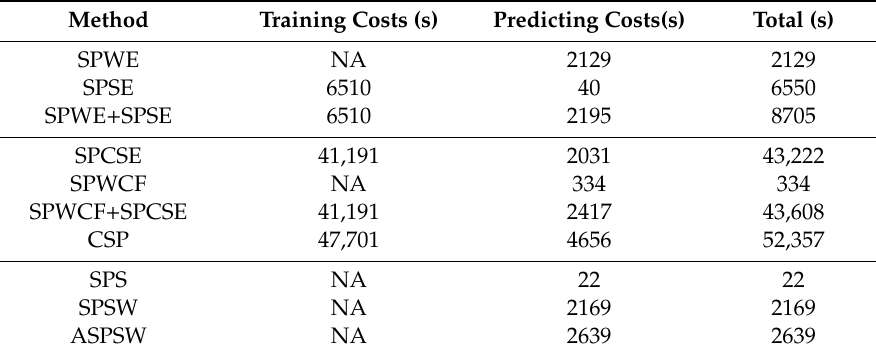
Table 5. Time consumption for predicting sememes of 5000 unlabeled